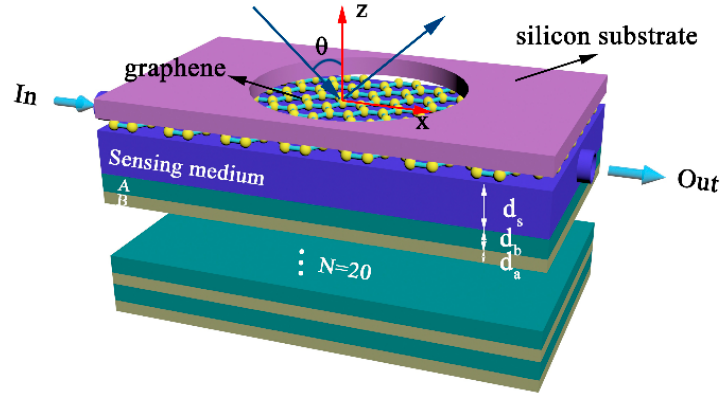
Figure 1. Schematic diagram of the proposed terahertz sensor, where the graphene is coated on the sensing medium and fastened by a fixing device, while a one-dimensional photonic crystal (1D PC) is beneath the sensing medium.